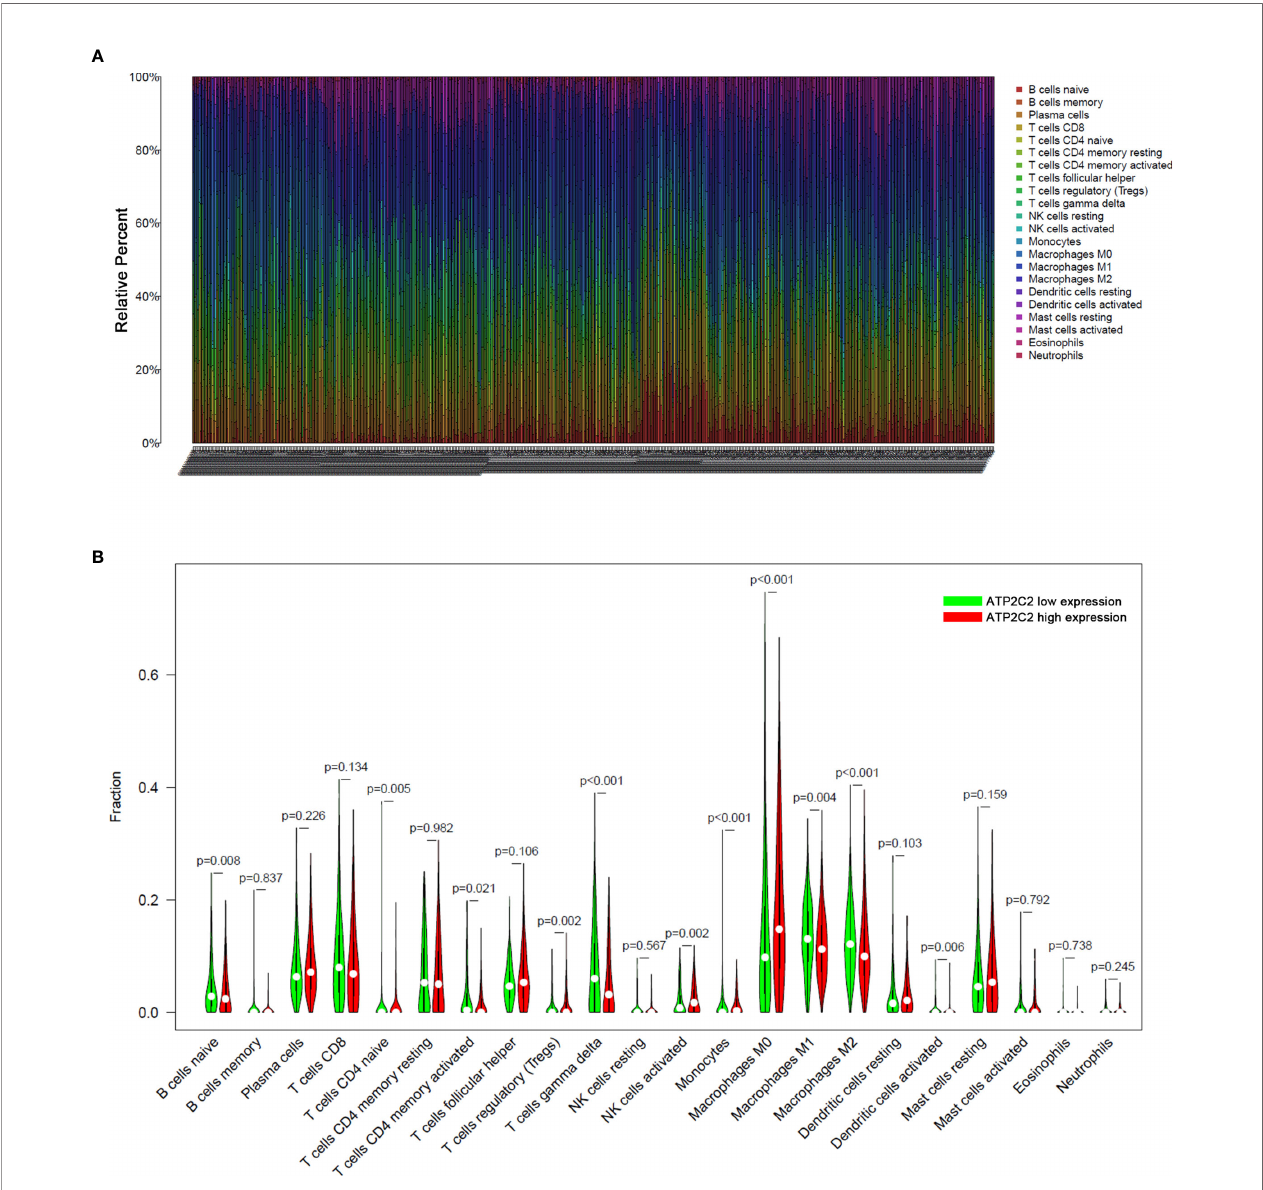
FIGURE 7 | Analysis of immune cell in fi ltration. (A) Fraction data of the 22 types of immune cells. (B) Differential immune cell type expression was observed between the high and low-ATP2C2 groups. Signi fi cant statistical differences between the two subgroups were assessed using the Wilcoxon